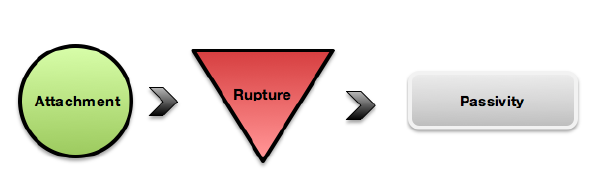
Figure 1 | The three-step narrative design model of sadness. As proposed by Zagalo et al.